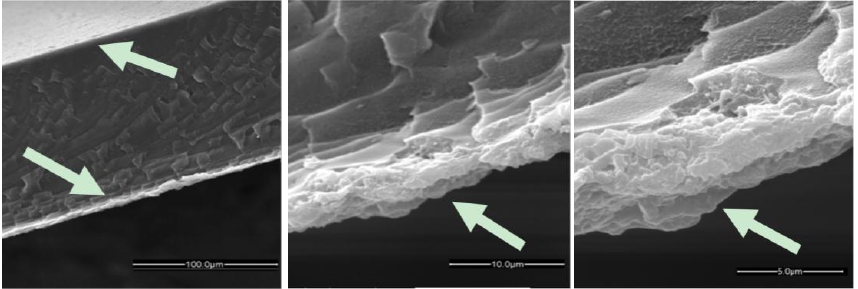
Figure 8. Cross-section of the HKUST-1/HMDA-PIM-1 membrane after five days of growth. The arrows indicate the HKUST-1 layer.